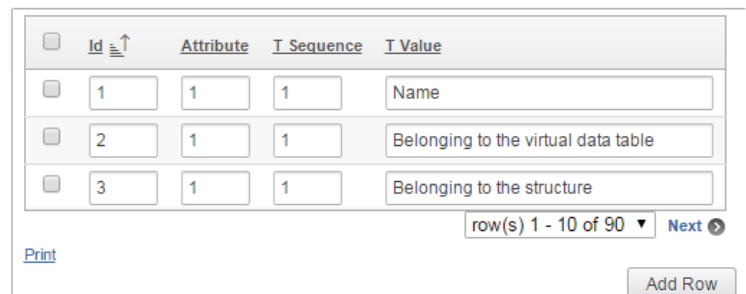
Figure 2. Storage of basic attributes.